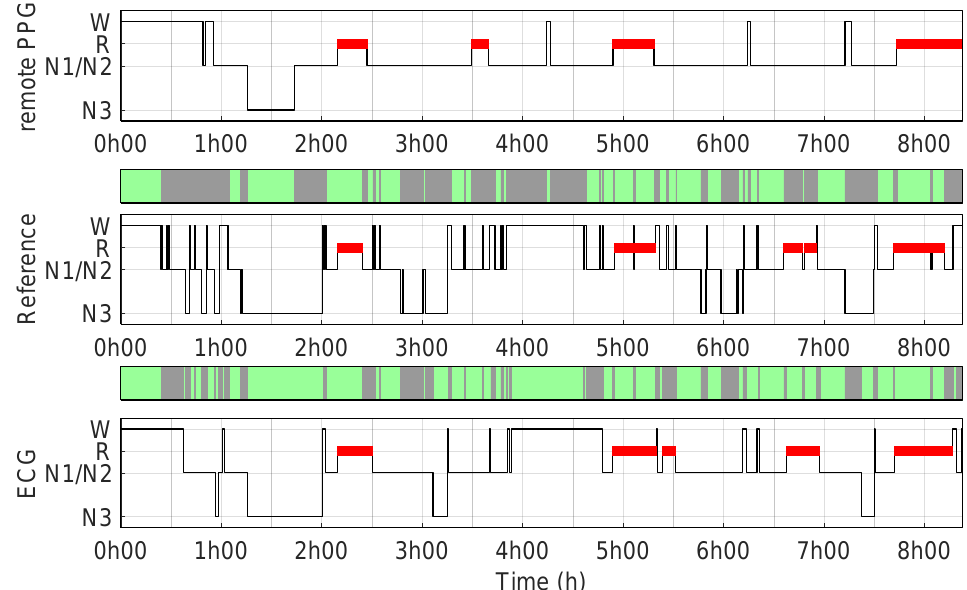
Figure 4. Hypnogram with a higher wake classification sensitivity with ECG than with Remote PPG. Hypnograms for one example recording of a participant where ECG achieved a higher wake classification sensitivity than with remote PPG; ( top ) Hypnogram predictions using remote PPG, ac- curacy 55%, κ remotePPG = 0.34 vs. reference PSG; ( middle ) reference hypnogram based on PSG manual scoring; ( bottom ) hypnogram predictions using ECG, accuracy 75% κ ECG = 0.65 vs. reference